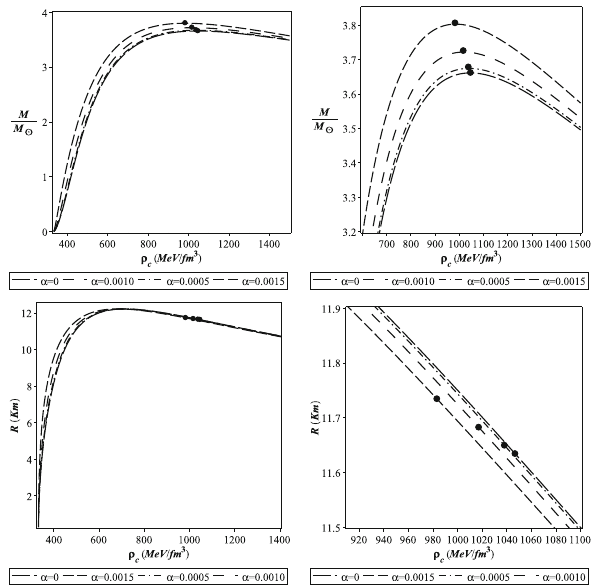
Fig. 7 Variation of the (i) mass M / M (cid:8) (upper left panel) and (ii) radius R in km (lower left panel) of the strange stars as a function of the central density (ρ c ) are shown. The enlarged versions of the M / M (cid:8) vs (ρ ) and R vs (ρ ) curves are shown in the upper right panel and the c c lower right panel. Here, solid circles are representing maximum mass points